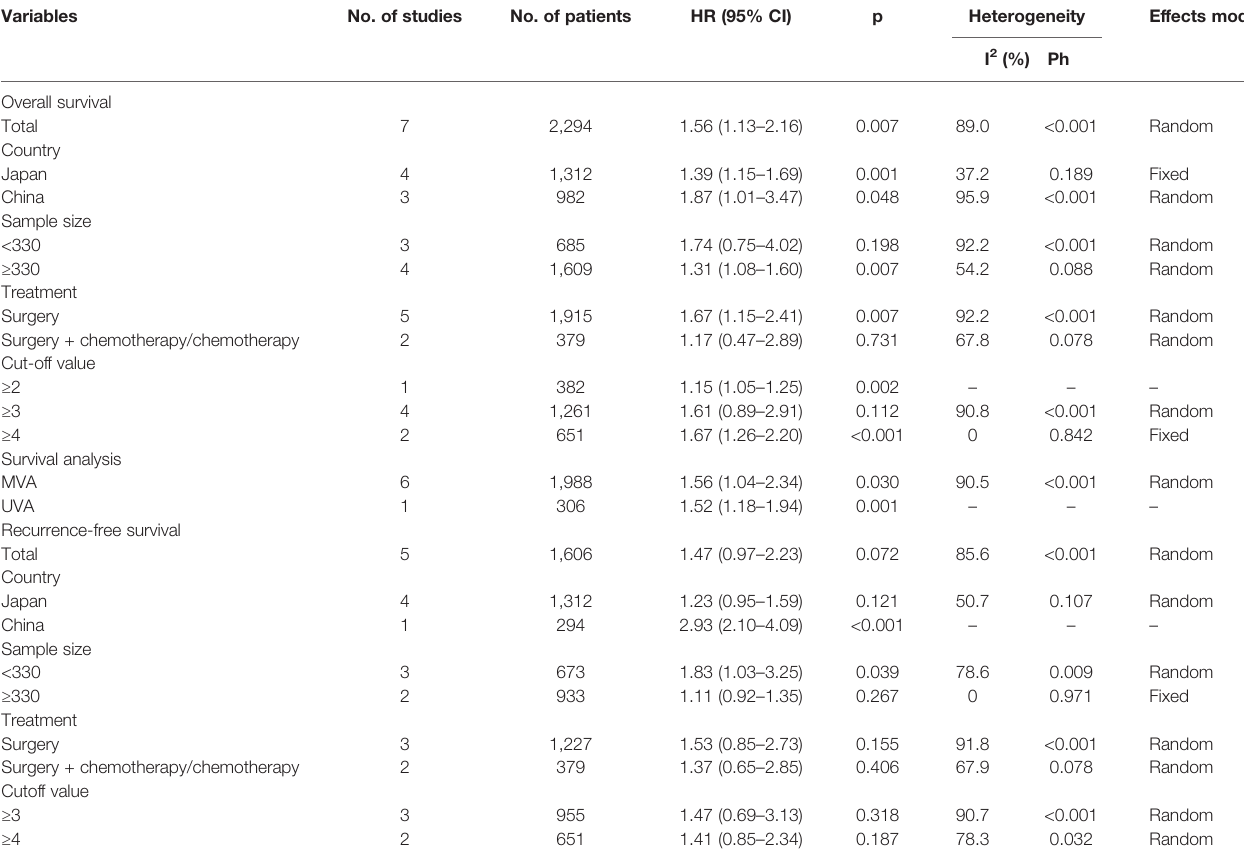
TABLE 3 | The prognostic value of COUNT score for OS and RFS in pancreatic cancer and subgroup analysis.